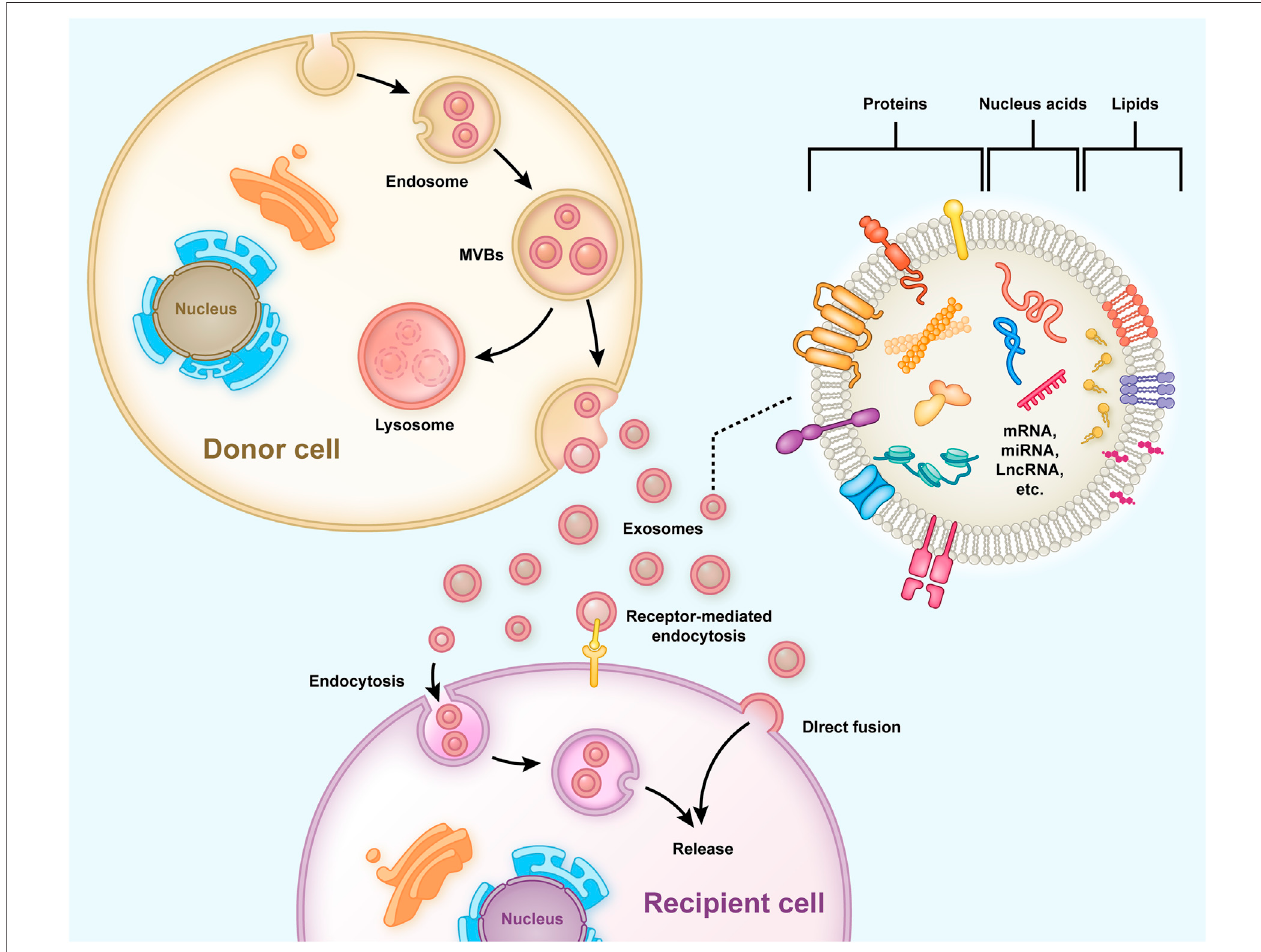
FIGURE 1 | Typical process of exosome generation, secretion, and transfer from the donor cells to the recipient cells, and the exosome structure is shown. Early endosomes containing ILVs are formed preliminarily and then developed into mature MVBs to release and form exosomes into the extracellular. The exosomes have a bilayered membrane structure containing functional proteins, nucleic acids (mRNA, miRNA, lncRNA, etc.), and lipids, some of which are released into recipient cells to regulate gene expression and cell function.